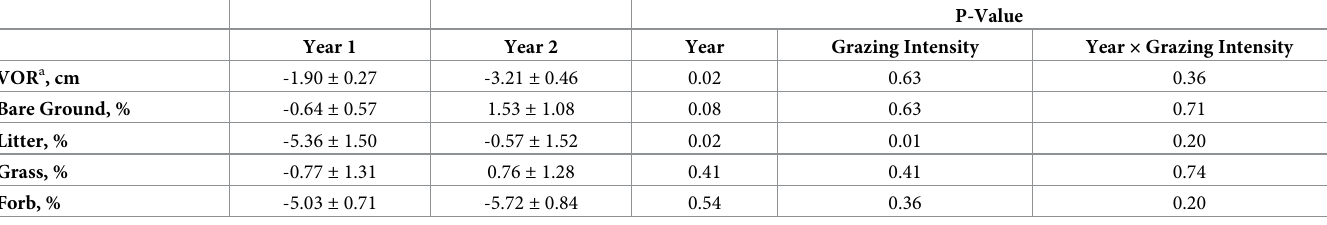
Table 6. Pre-post difference in heterogeneity (as indexed by differences in standard deviation ± SE) of visual obstruction and residual cover classifications by year for cattle grazing dormant rangeland in 2016 – 2017 & 2017 – 2018 at the Northern Agricultural Research Center Thackeray ranch, Havre,